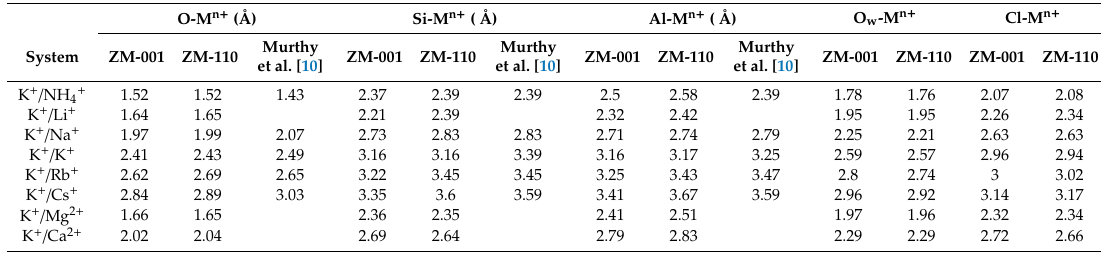
Table 2. The nearest distances of M n + ions to framework atoms and oxygen of water molecules (O w -M n + ), within membranes and comparison with previous work [10]. O-M n + (Å)